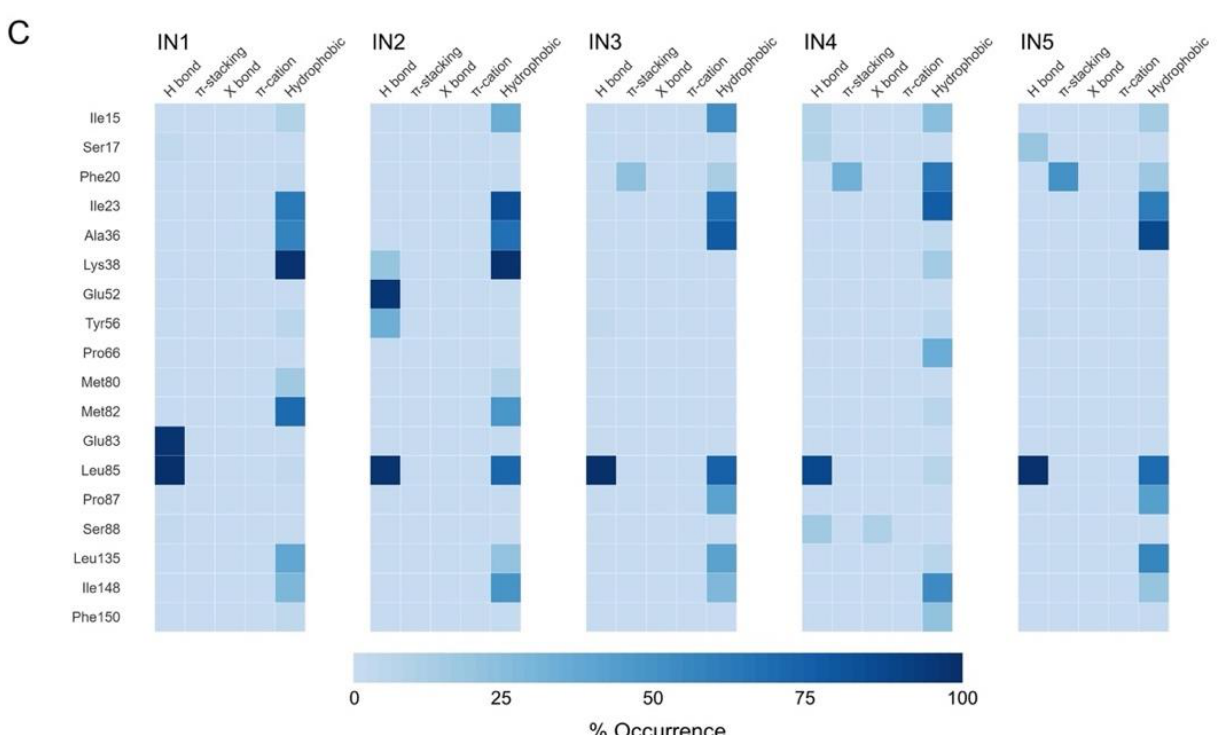
Figure 3. Molecular dynamics analysis identified key inhibitor-CK1 ε interactions. ( A ) Protein backbone and ligand RMSDs for apoCK1 ε and CK1 ε -inhibitor complexes. ( B ) Protein backbone RMSF for all systems. Secondary structure of CK1 ε is shown at the bottom with regions comprising the catalytic domain in red squares. ( C ) Heatmap of the non-covalent interaction profile occurrence. For clarity, only residues with occurrence higher than 20% are